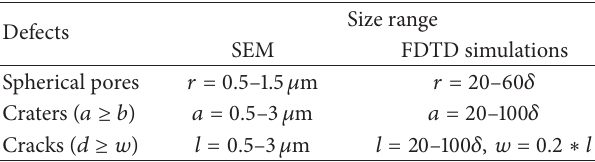
Table 1: The size range of different defects.